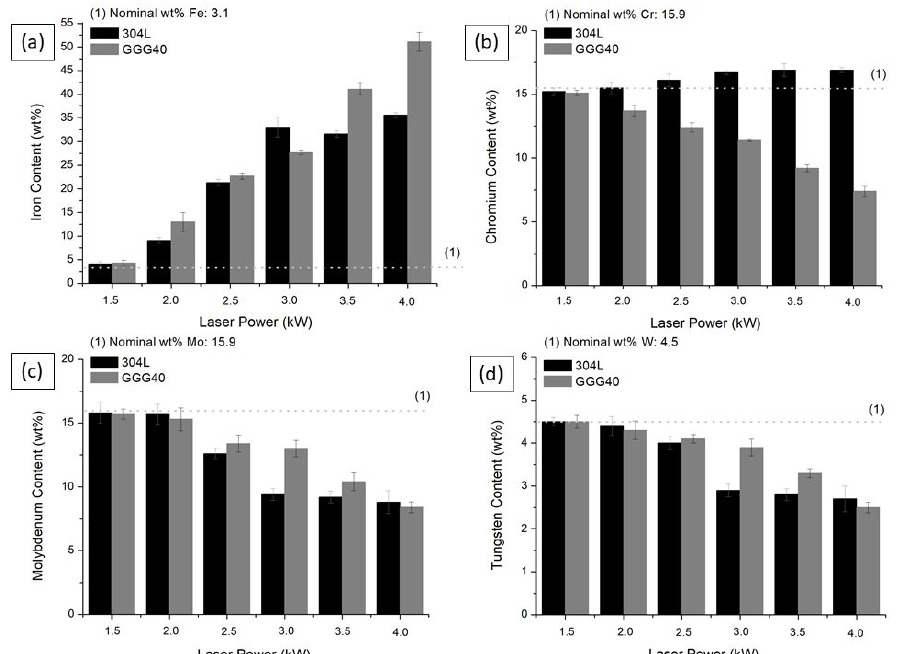
Figure 11. Alloying elements’ content measured by EDS versus laser power.